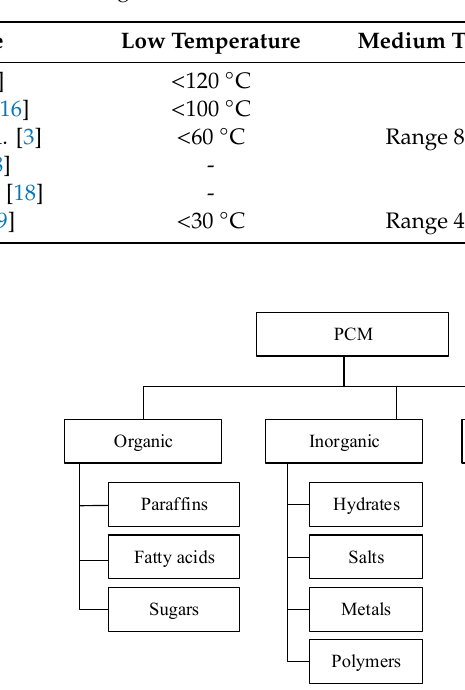
Table 1. Phase change materials classification, according to phase change temperature.